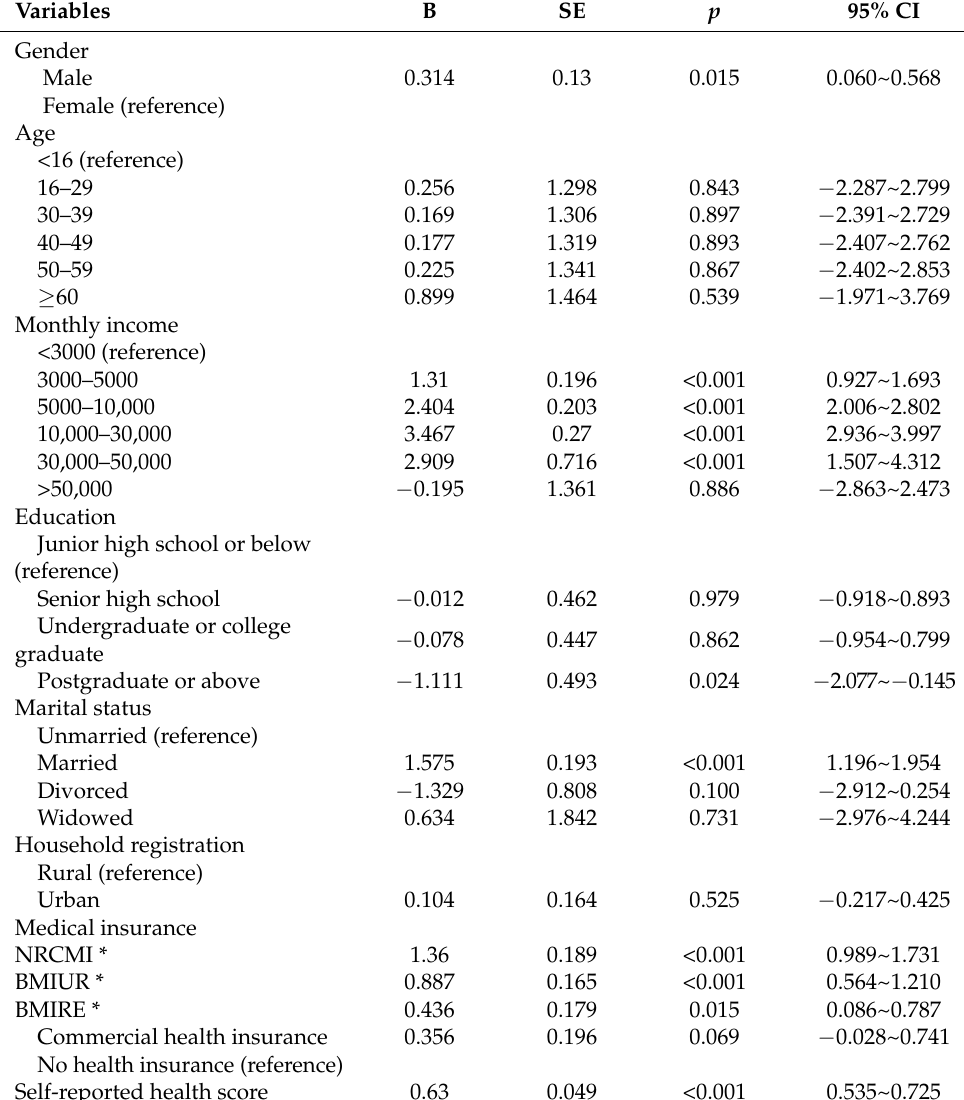
Table 3. Factors influencing the perception of the quality of primary healthcare